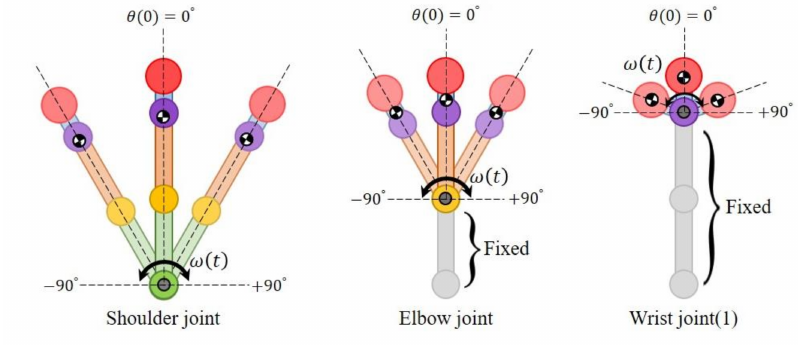
Figure 5. Motion schematic to analyze the maximum torque of each